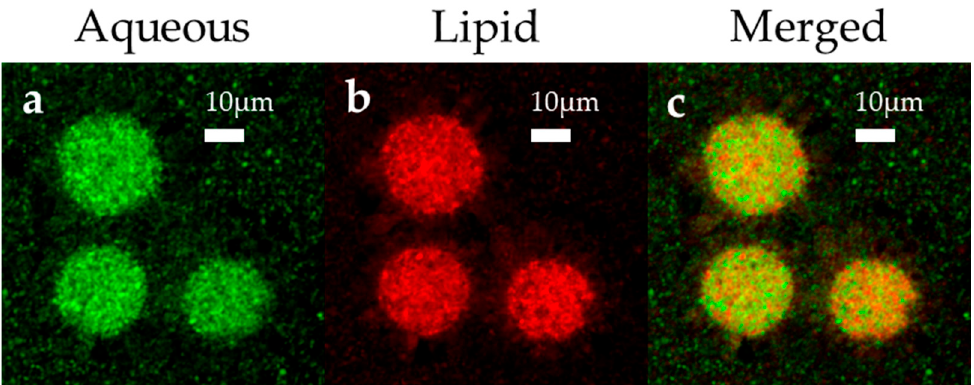
Figure 4. Confocal microscopy images of fluorescent probe-loaded MVL: ( a ) aqueous probe (BODIPY ® 492/515), ( b ) lipid probe (rhodamine B 1,2-Dihexadecanoyl-sn-Glycero-3-Phosphoethanolamine, rhodamine-DHPE), and ( c ) merged image (green and red represent the aqueous and lipid phases, respectively). The confocal microphotograph was captured at 60× magnification.